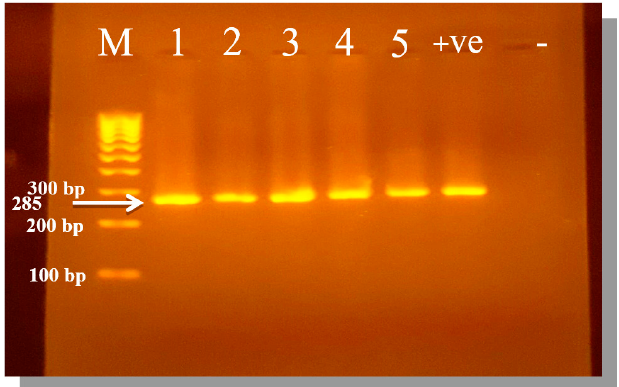
* Rate of M. bovis from the positive Mycoplasmal samples ** Rate of M. bovis from the total lungs samples